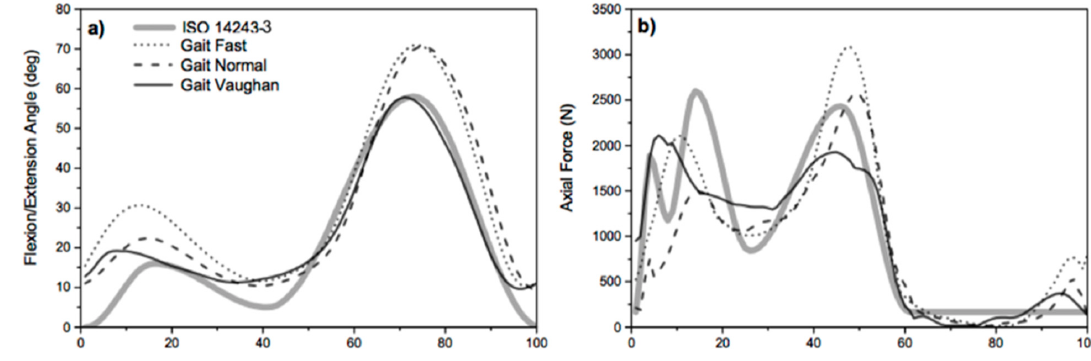
Figure 2. Comparison between in silico: flexion/extension angle ( a ), axial force ( b ), anterior/posterior 188 force ( c ), and rotational torque ( d ) from three gait types and the ISO 1423-3 values. 189